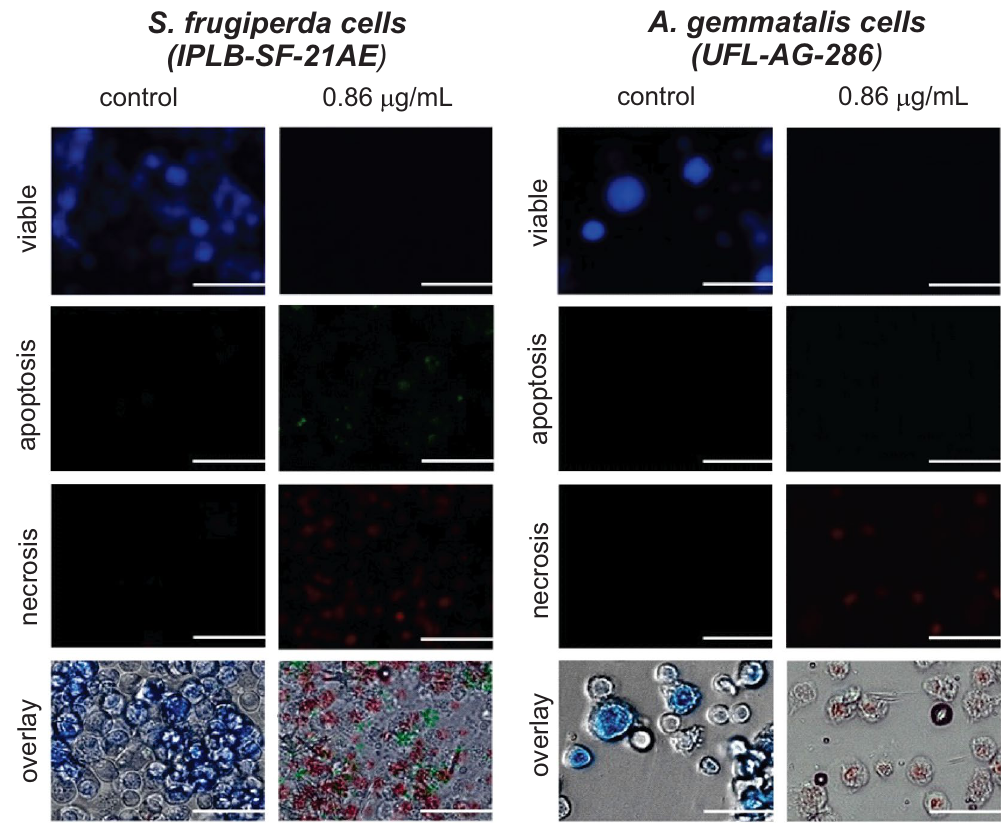
Figure 3. Cytopathic effects of the essential oil of Siparuna guianensis (0.86 mg/mL) on the viability of lepidopteran cultured cells from Spodoptera frugiperda (IPLB-SF-21AE) and Anticarsia gemmatalis (UFL-AG-286) visualized under fluorescence microscopy.